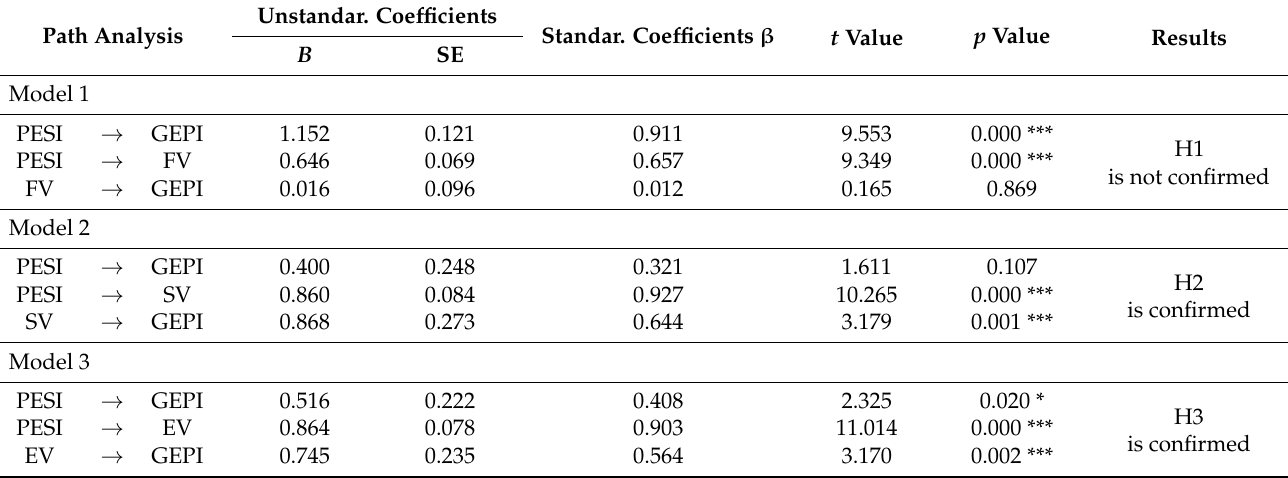
Table 4. Results of structural equation